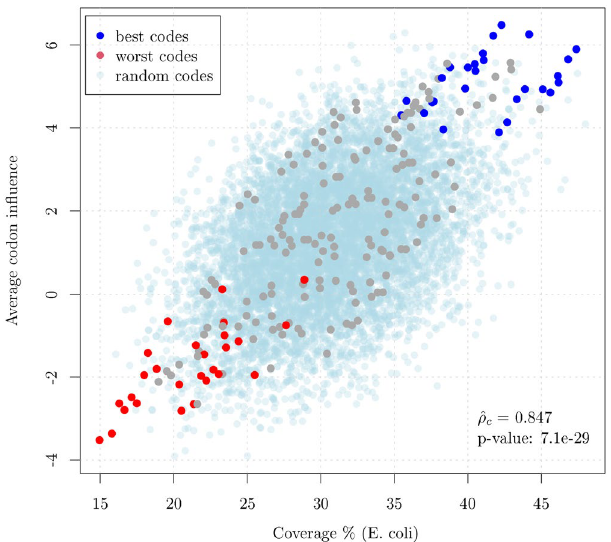
Figure 4. Average codon influence versus Coverage (percent) computed on the 216 circular codes partitioned in 27 equivalence classes of 8 codes each. The points in blue and red correspond to the 27 best and 27 worst codes within their associated equivalence class, respectively. As for the speed of translation (Fig. 3), the coverage is a predictor of codon influence and the best and worst codes within their equivalence class clusterize. The results for 8000 random codes are also shown in light blue and the p -value for the test that the observed correlation is equal to that of random codes is reported.